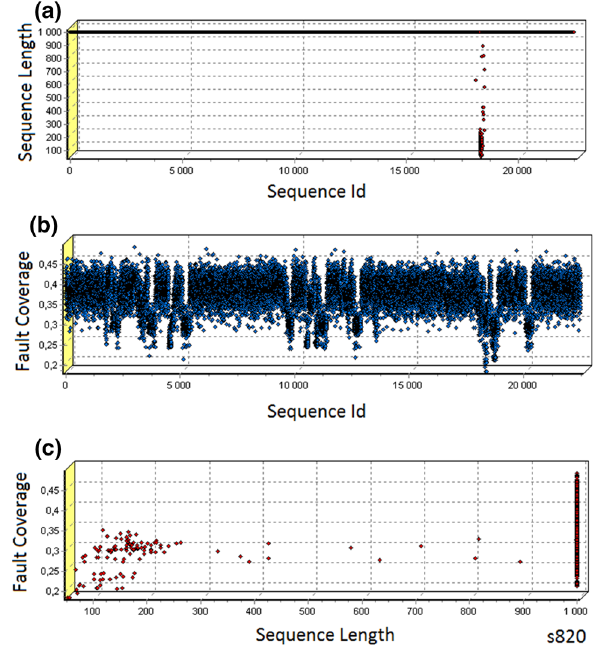
Fig. 14 Simulation graph for s820 a sequence length vs. sequence id, b FC vs. sequence id and c FC vs. sequence length. STP (Id